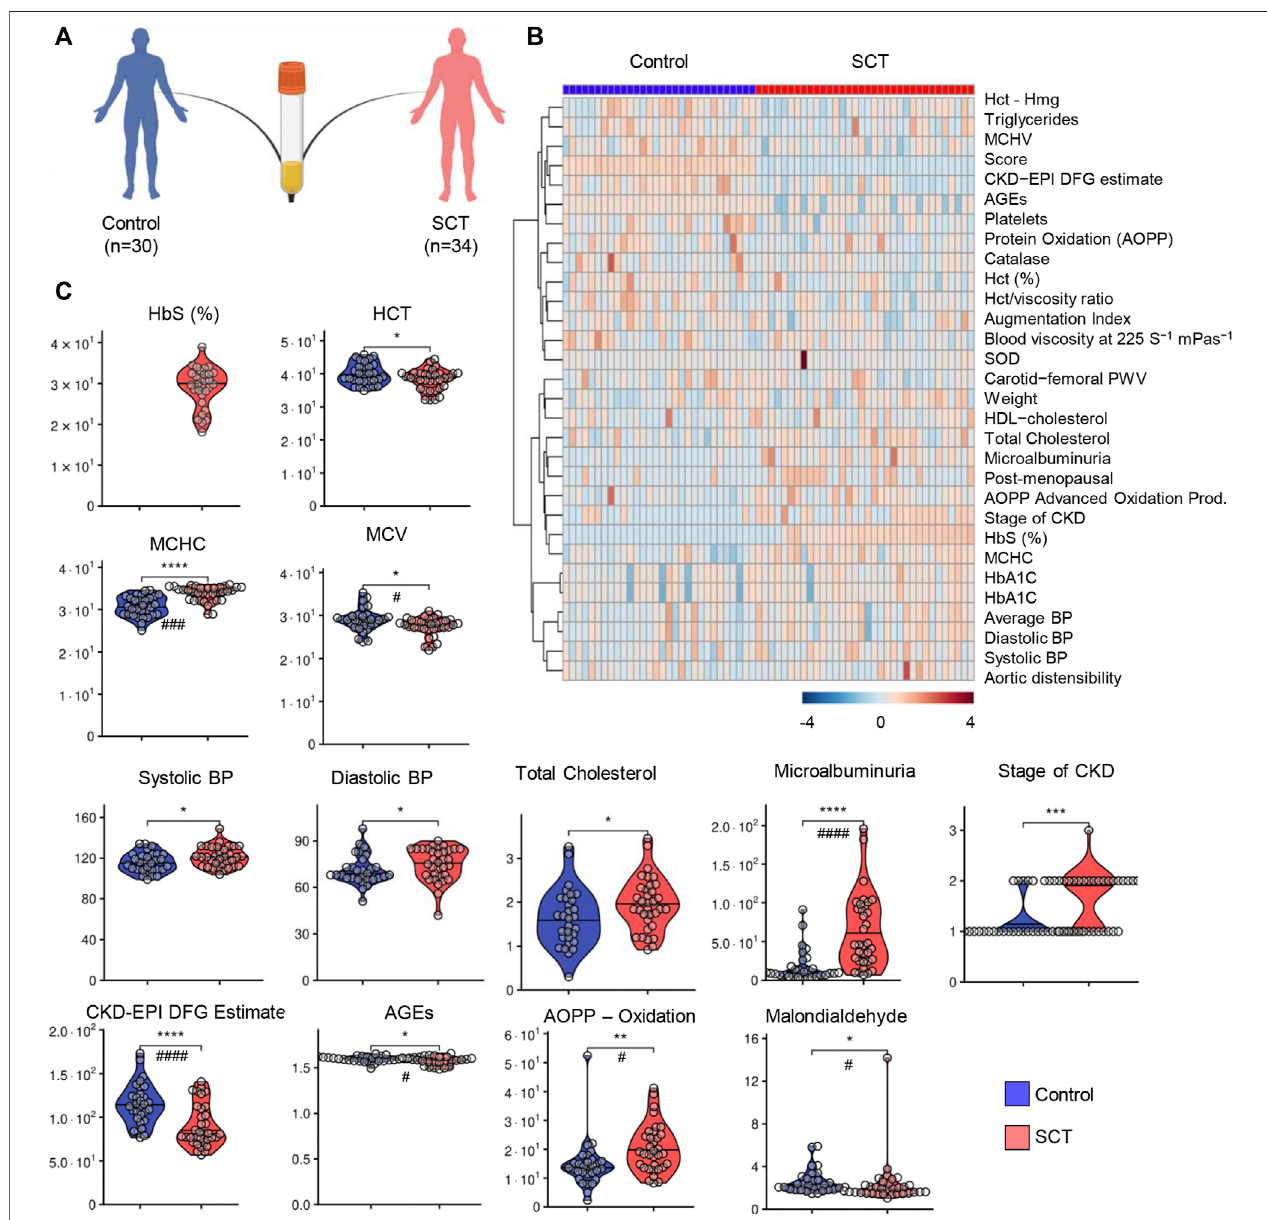
FIGURE 1 | Study design, hematological and clinical parameters. A total of 64 subjects ( n = 30 in the control group — blue and n = 34 in the sickle cell trait — SCT group — red) were enrolled in this study (A) . Hierarchical clustering of clinical and hemorheological parameters is shown in panel (B) . Violin plots (C) show signi fi cantly different hematological parameters between the two groups, including % Hemoglobin S (HbS), hematocrit (%), mean cell hemoglobin concentration (MCHC), mean cell volume (MCV); markers of kidey fi ltration (microalbuminuria) and chronic kidney disease or EPI DFG estimates. Markers of oxidant stress (advances oxidation protein products), total cholesterol levels were also signi fi cantly different between the two groups. However, no signi fi cant differences were noted with respect to the levels of multiple interleukins (IL-6, IL-8, IL-10 and TNF α — Supplementary Figure S1 ). Asterisks indicate signi fi cance (* p < 0.05; ** p < 0.01; *** p < 0.001; **** p < 0.0001 Wilcoxon/Mann-Whitney U -test). FDR-corrected p -values are provided for all analytes in Supplementary Table S1 and indicated with # using the same signi fi cance ranges as per the asterisks in p -values above.